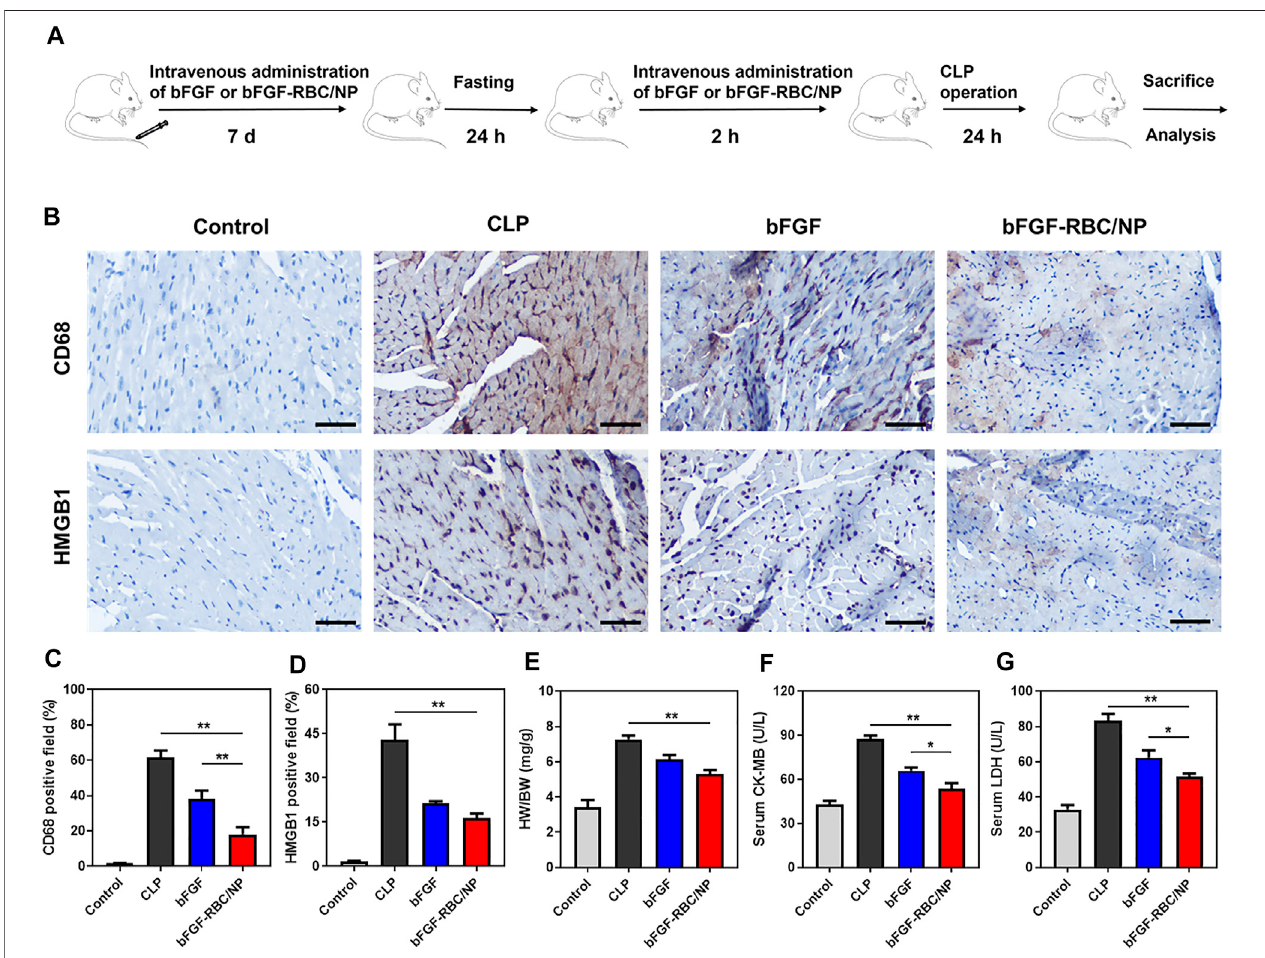
FIGURE 5 | Therapeutic effects of bFGF-RBC/NP. (A) Timeline of the experimental procedure. (B) Representative immunohistochemical staining results of CD68 and HMGB1 in heart tissues. The quantitation of positive cells of (C) CD68 and (D) HMGB1 in each group. (E) Heart weight/bodyweight (HW/BW) index of each group. (F) CK-MB and (G) LDH levels in serum. Data are expressed as the mean ± SD ( n = 3). Scale bar = 50 um. * p < 0.05 and ** p <